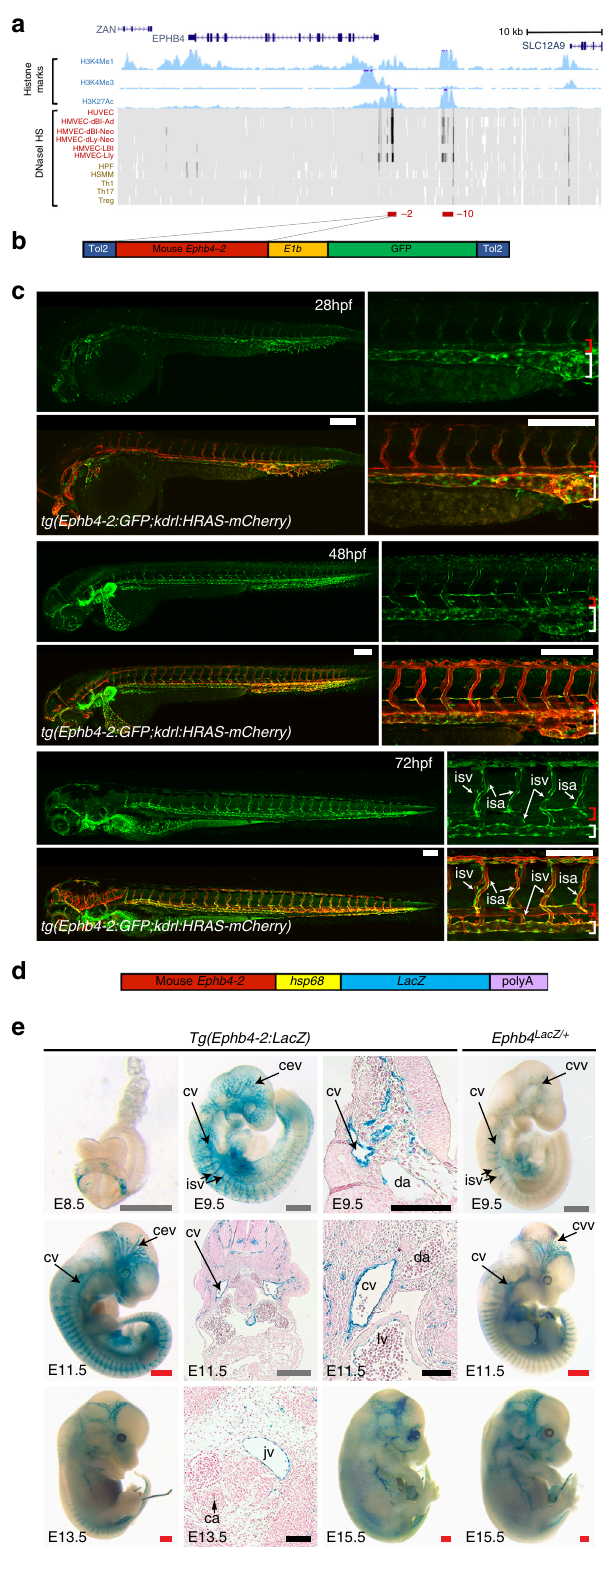
zebra fi sh or relate to the high levels of proliferation seen in these zebra fi sh vessels 31 . In conclusion, this enhancer analysis clearly demonstrates that the mouse Ephb4-2 sequence represents a venous-speci fi c enhancer for Ephb4 that closely mimics the expression of the endogenous gene in mice, providing us with a